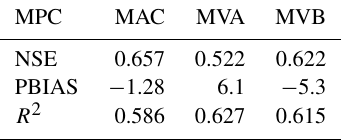
Table 4. Model performance during calibration and verification stages. MPC MAC MVA